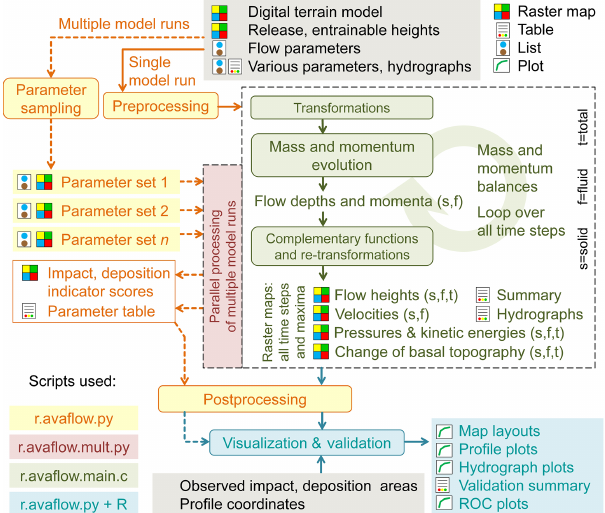
Figure 1. Logical framework of r.avaflow. The transformations and retransformations refer to the conversion of heights and GIS coor- dinates to depths and topography-following coordinates, and vice versa (see Sect.